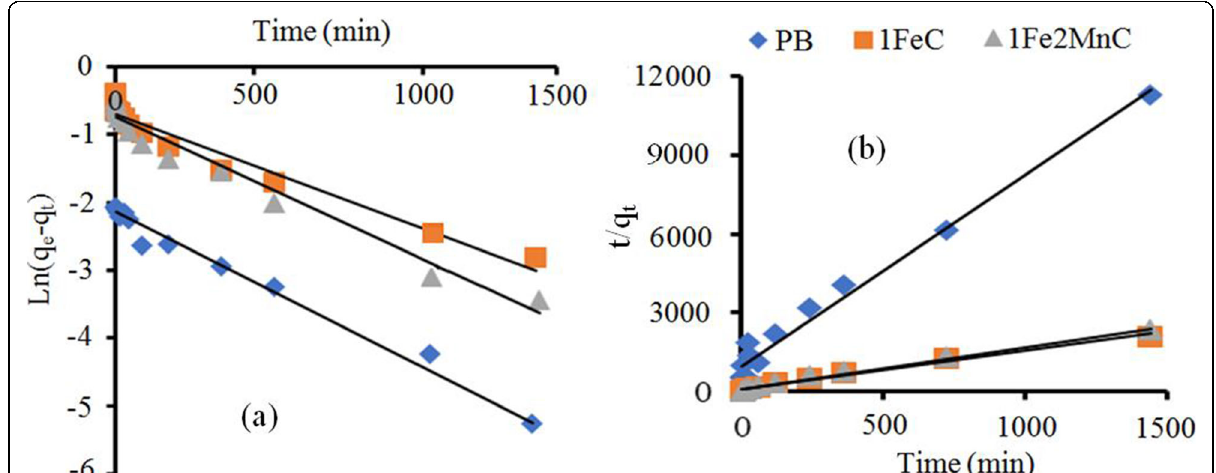
Fig. 12 Kinetic adsorption curves of As on materials: a Pseudo-first-order and b Pseudo-second-order